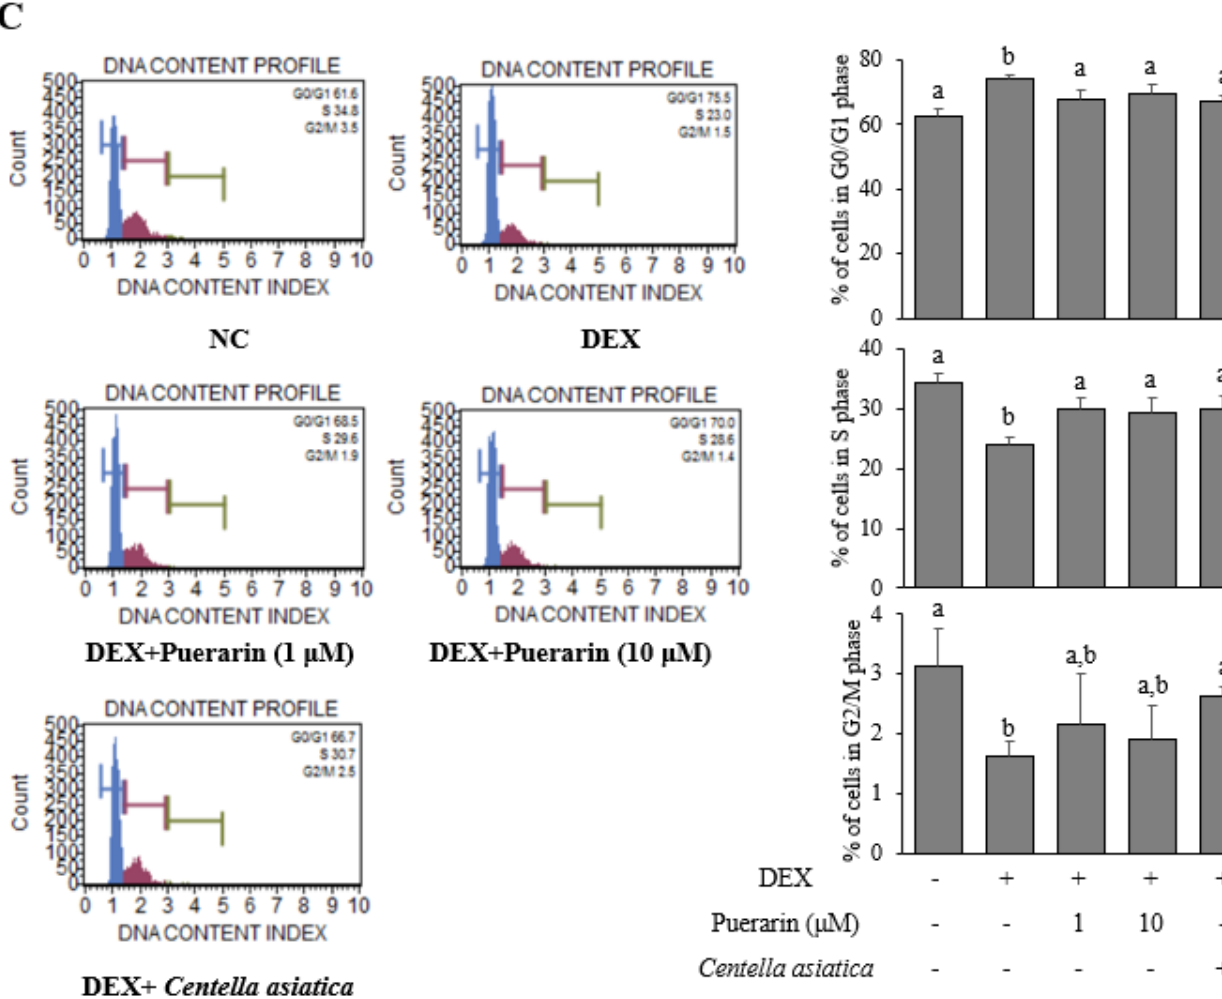
Figure 2. Effects of puerarin on the proliferation of HaCaT cells stimulated with DEX. HaCaT cells were incubated with DEX (100 nM) and puerarin (1, 10 μ M) or Centella asiatica extract (100 μ g/mL) for 48 h. ( A ) Ki67 expression was assessed using a Muse Ki67 Proliferation kit. ( B ) Protein levels of K16 and K17 were determined by Western blotting. ( C ) Cell cycle analysis was performed using a Muse Cell Cycle kit. The results are presented as the means ± SDs of three independent experiments. Bars labeled by the same letter on the graph are not significantly different from each other ( p < 0.05) by one-way ANOVA followed by post hoc Tukey’s test.